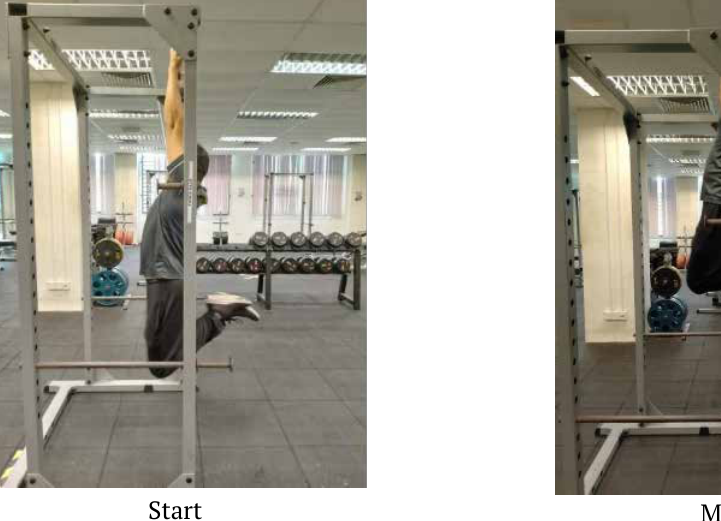
chin-upStart Figure 3. Starting and middle position of full knee flexed knee Table 2. EMG reading of concentric phase during chin up between positions EMG Straight knee Partial knee flexed Knee fully flexed LD mean (% MVIC) 70.50 ± 6.09 72.99 ± 3.15 71.25 ± 6.10 PD mean (% MVIC) 55.10 ± 4.21 56.20 ± 7.47 57.99 ± 5.15 BB mean (% MVIC) 69.38 ± 4.97 b, c 61.51 ± 5.21 a 60.35 ± 3.85 a